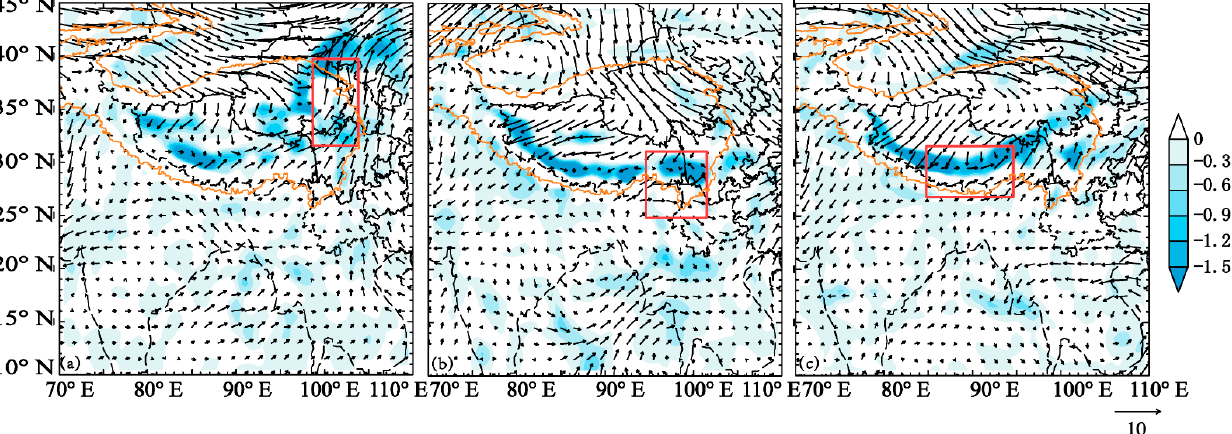
Figure 11. The 500 hPa water vapor flux divergence (shade, unit: 10 − 7 g · cm − 2 hPa − 1 s − 1 ) and water vapor flux (vector, unit: 10 − 3 g · cm − 1 hPa − 1 s − 1 ) over the Tibetan Plateau for ( a ) PT-type, ( b ) PSL-type, and ( c ) the PV-type extreme precipitation events. The red box represents the extreme precipitation area, while the yellow boundary lines represent the Tibetan Plateau.